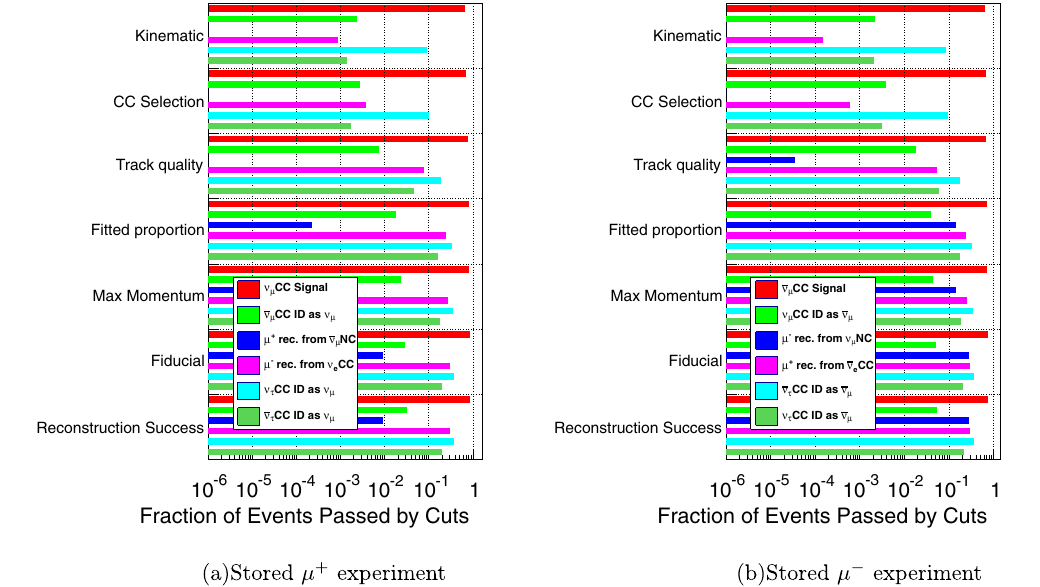
FIG. 8. Effect of the cuts on the detection of signal and background events assuming a magnetic field that focuses negatively charged